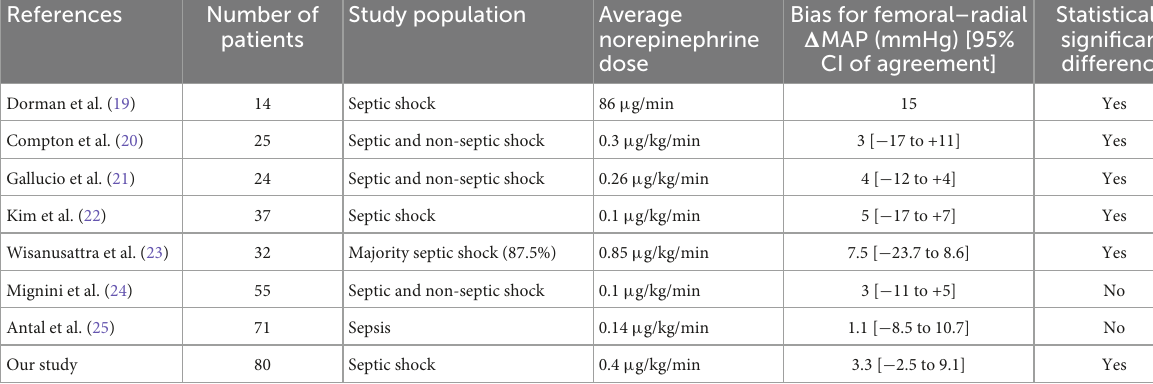
TABLE 5 Summary of studies examining differences in mean arterial pressure (MAP) between the femoral and radial sites in critically ill septic shock